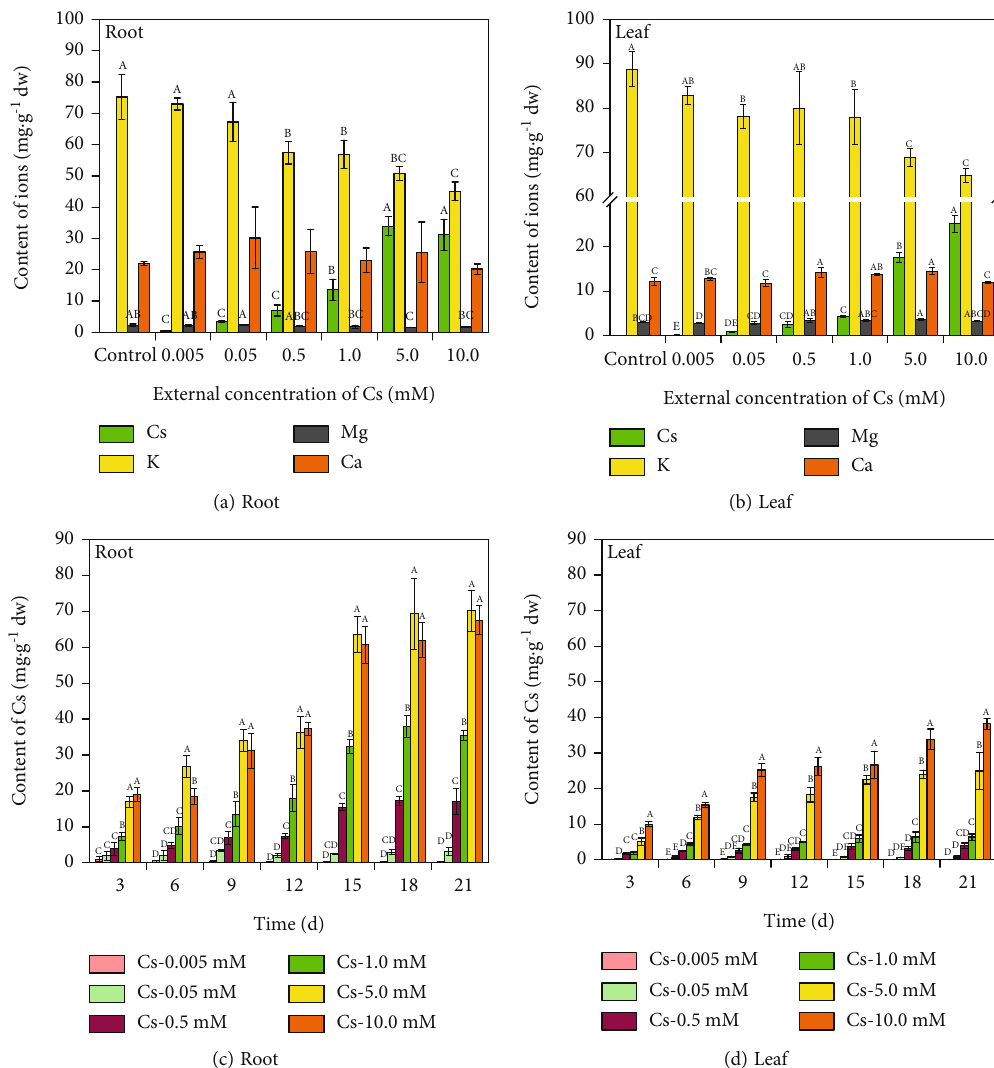
Figure 3: E ff ects of di ff erent Cs + concentrations and sampling time on the content of each element (Cs, K, Mg, and Ca) in lettuce. (a) and (c) represented changes of element content in root. (b) and (d) represented changes of element content in leaf. Notes: the di ff erent lowercase letters indicate that signi fi cant di ff erences ( P < 0 : 05 ) exist between treatment groups with di ff erent Cs levels in lettuce (LSD